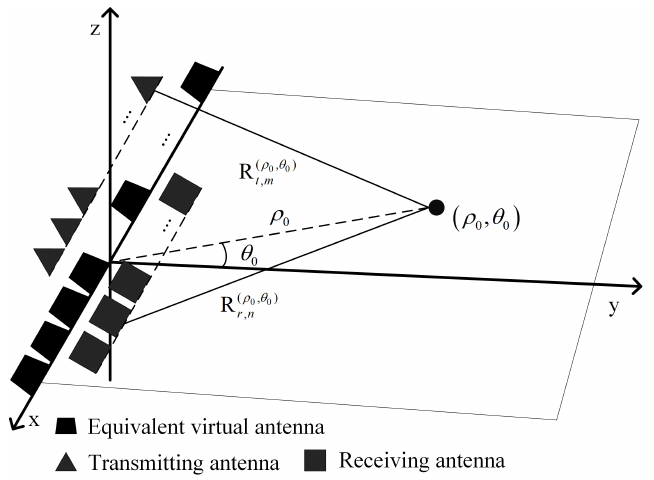
Figure 5. Geometric model of data collection for non-collinear array MIMO radar.